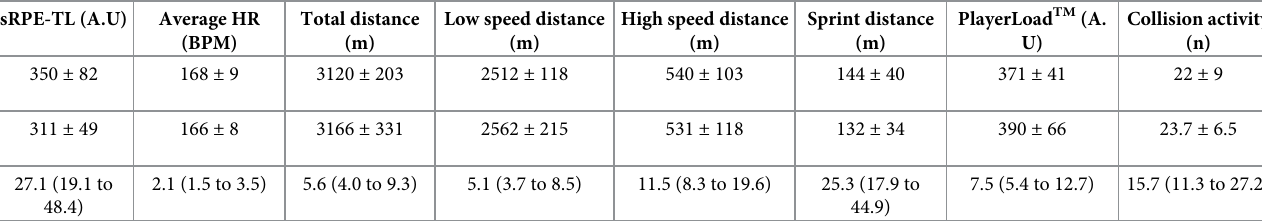
Table 1. Session training load. sRPE-TL (A.U)